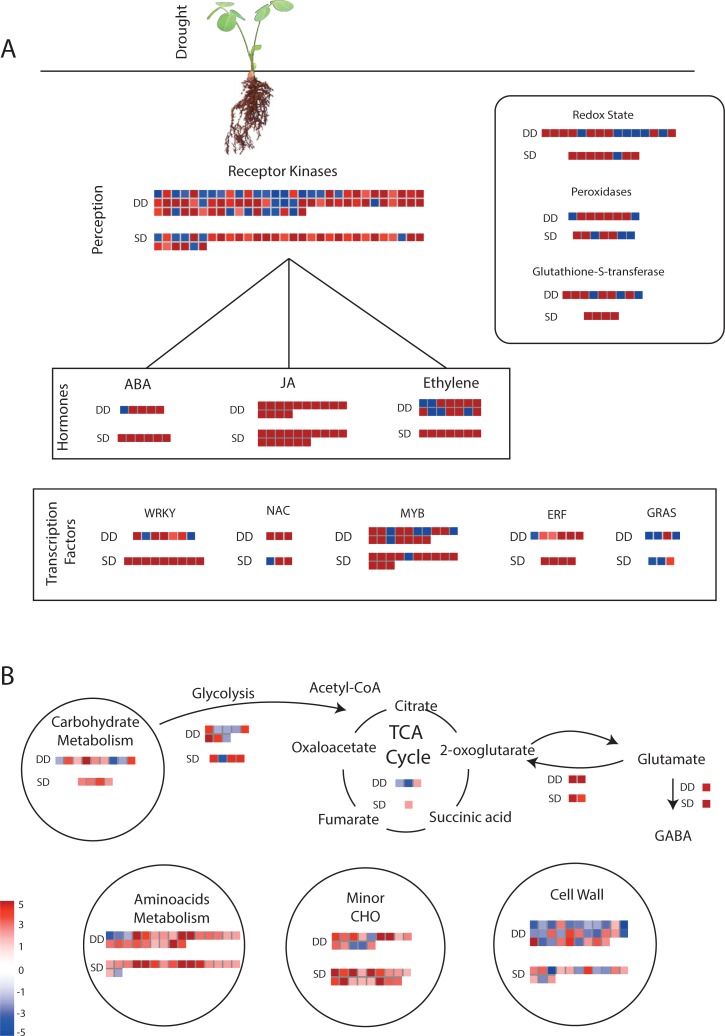
Overview of DEGs expression patterns.MapMan analysis showing molecular functional categories of DEGs expression patterns in roots of dehydration-stressed plants of A. duranensis (DD) and A. stenosperma (SD) relative to control. Squares show the different genes encoding proteins related to drought perception and oxidative responses (A) and carbohydrate and amino acid metabolism steps (B). Upregulated genes are indicated by red squares and downregulated by blue squares.